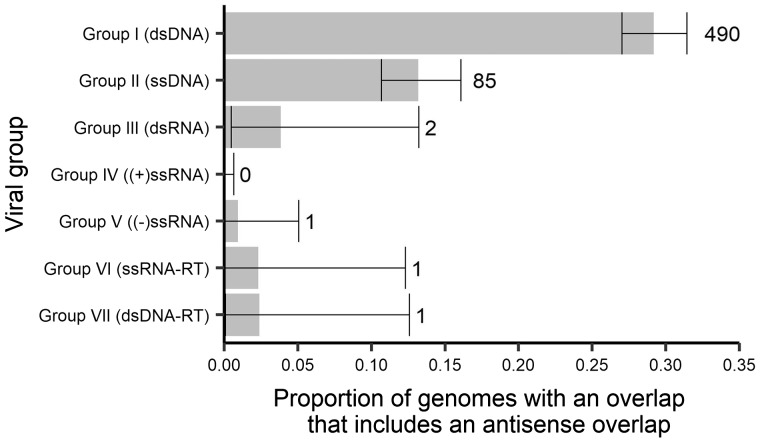
The proportion of genomes containing a gene overlap that has an antisense overlap in each virus group. Error bars represent 95 per cent CIs. Numbers to the right of error bars represent the number of genomes containing an antisense gene overlap (e.g. 490 genomes in Group I (dsDNA) contain an antisense gene overlap).